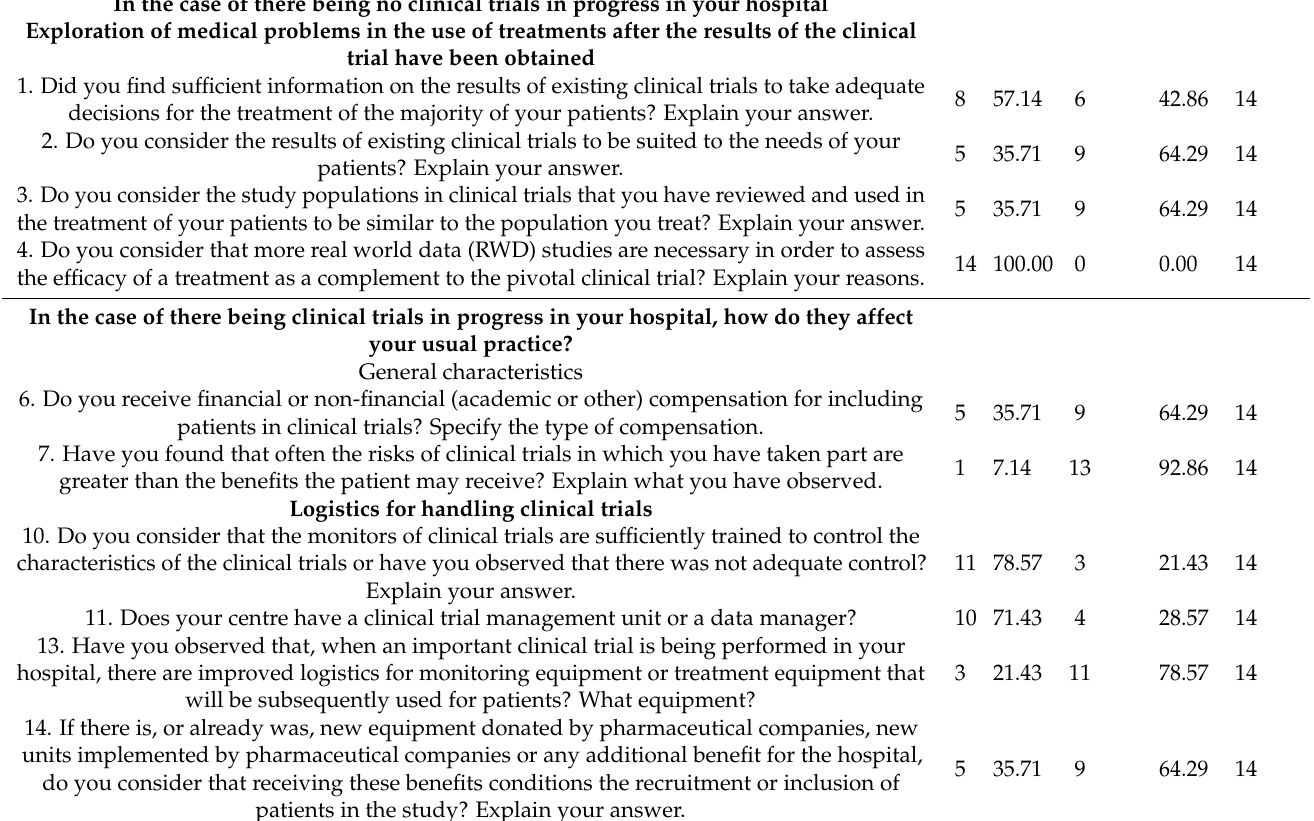
Yes No Total n % n